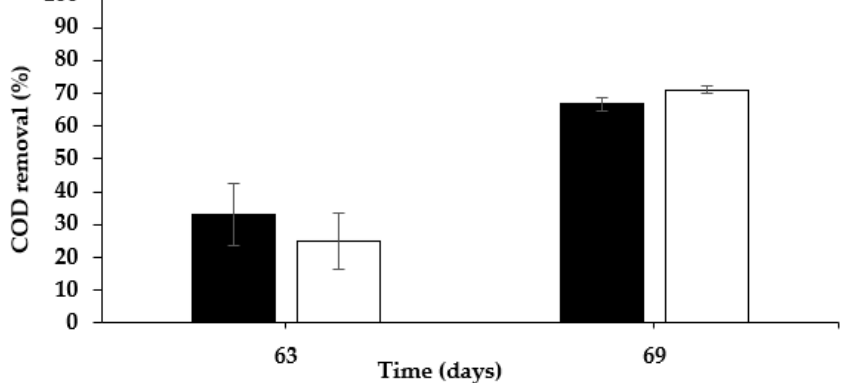
Figure 6. COD removal (%) in MEC-SBP ( ◼ ) and MEC-control ( □ ) supplied with artificial wastewater. p value ( t test): p > 0.05.